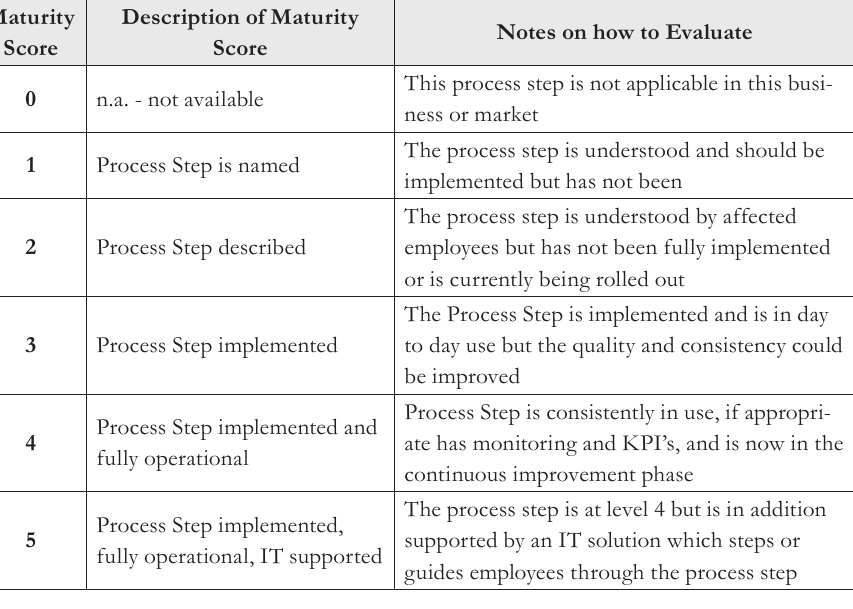
Tab. 2 – Guidelines for process maturity scoring. Source: